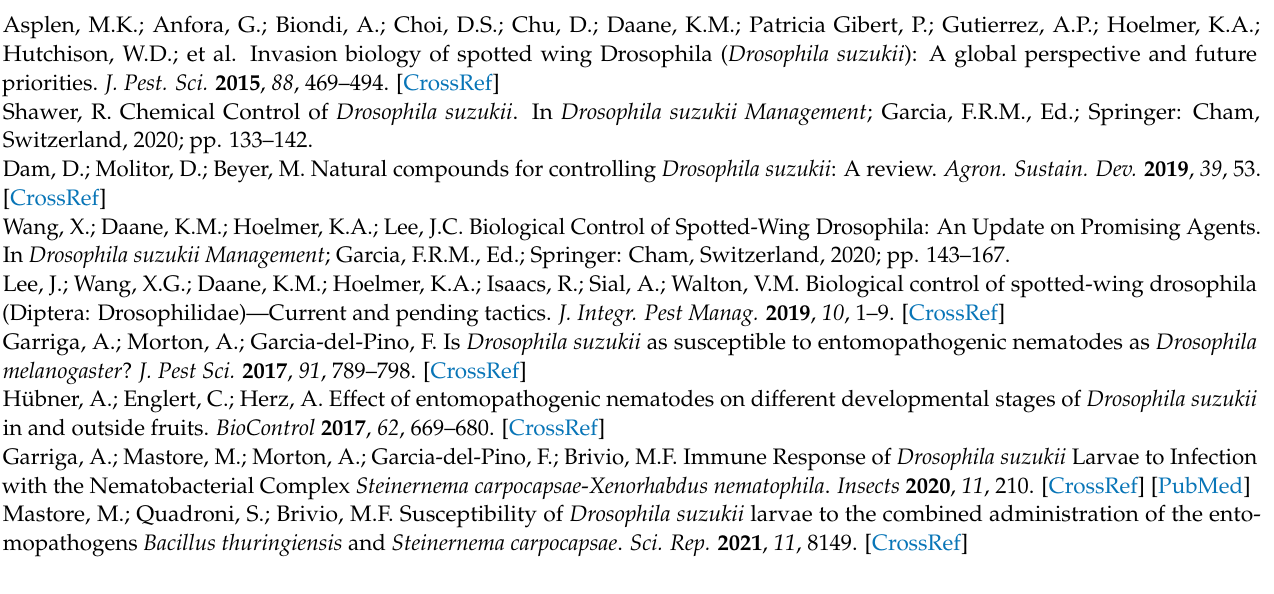
(Figure 1). Pairwise comparisons of SWD mortality by Tukey test between different Xn concen- trations at 24 and 48 h (A), and between different times within the same Xn concentration (reported as CFU/mL) (B). Significant p values ( p < 0.05) are indicated in bold italic and highlighted in yellow. C: Control = 0 CFU/mL. Table S2. Statistical results of bioinsecticides administration assays (both single—Figure 2—and combined—Figure 3—treatments). Pairwise comparisons of SWD mortality by Tukey test between different times within the same treatment (A) and between different treatments at 16, 24, 32, and 48 h (B). Significant p values ( p < 0.05) are indicated in bold italic and highlighted in yellow. Bt: Bacillus thuringiensis , Xn: X. nematophila , Sec: Xn secretions, C: Control, t 0 : concurrent administration, t 16 : time-shifted